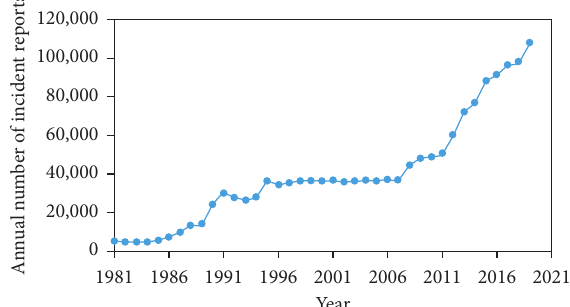
Figure 1: Annual incident reports ASRS received from 1981 to